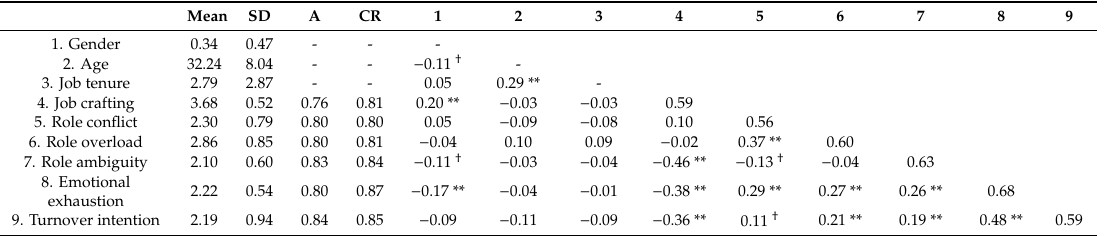
Table 2. Means, standard deviations, and correlations.